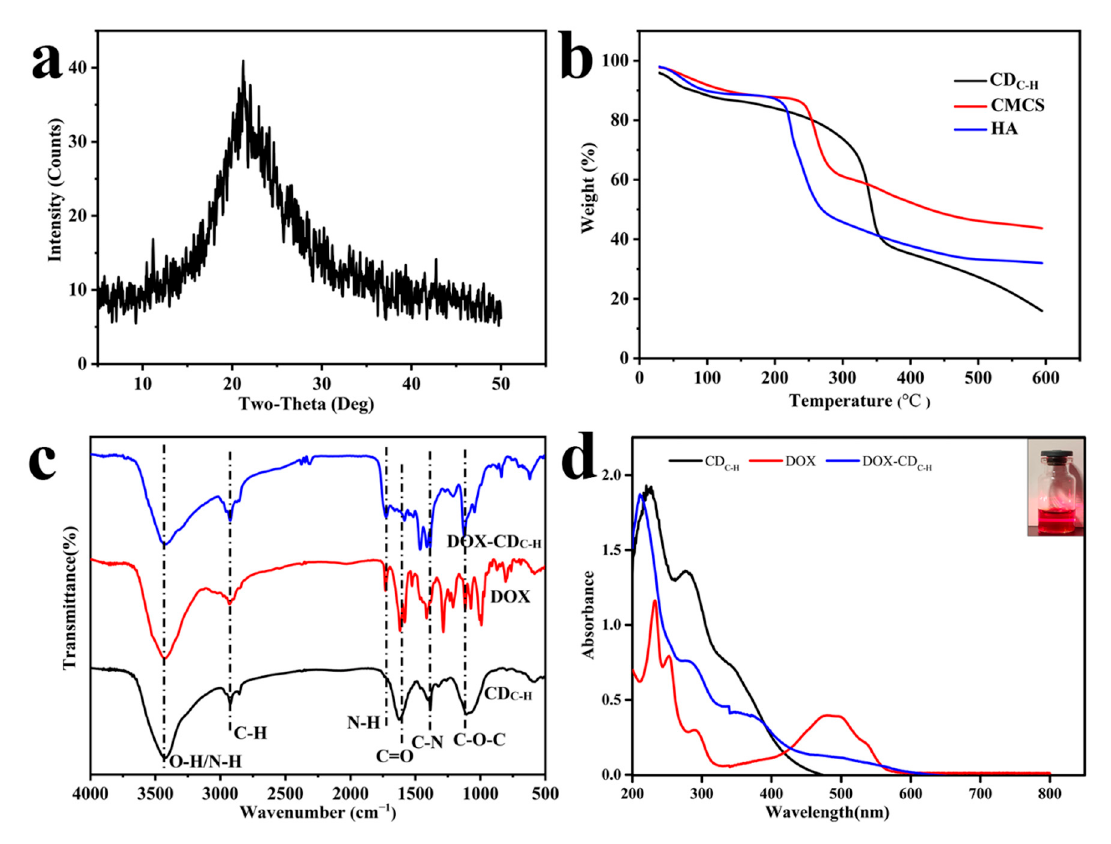
Figure 4. XRD pattern of CD C-H ( a ); TGA curve of CMCS, HA and CD C-H ( b ); FT-IR spectra of the CD C-H , DOX, and DOX–CD C-H complexes ( c ); UV–Vis spectra of DOX–CD C-H complexes ( d ). Table 2. The kinetic model correlation coefficients (R 2 ) of the in vitro release curve. Kinetic